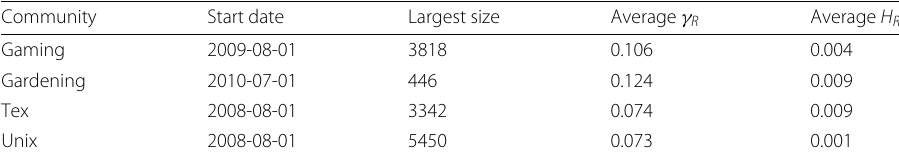
Table 3 Basic properties of four SE communities